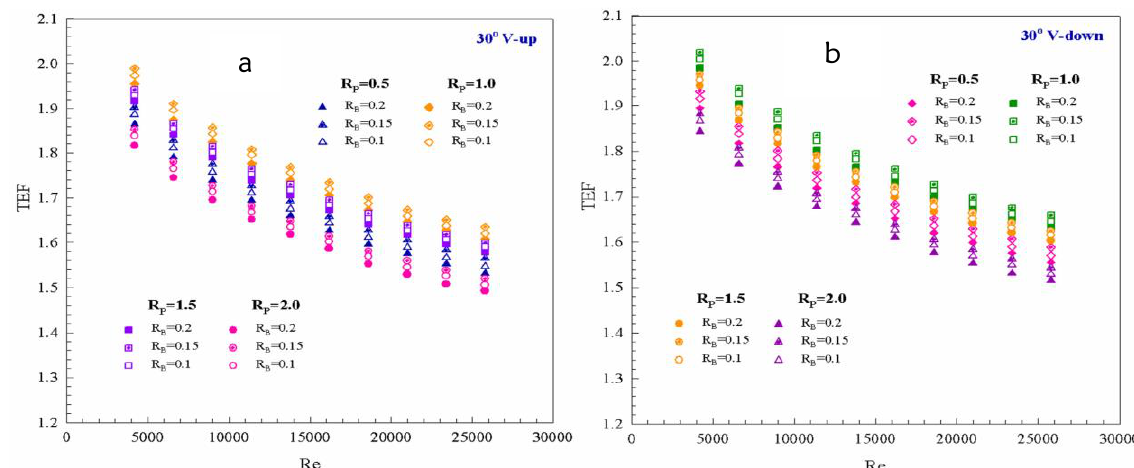
Figure 16: Variation of TEF with Re for (a) V-up DW inserts and (b) V-down DW inserts